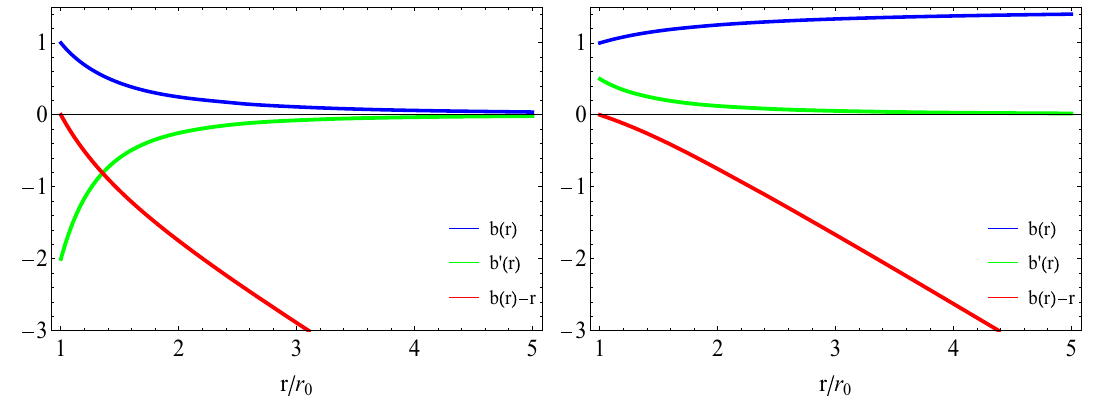
Fig. 2 These plots show the trend of the shape function (blue line), its first derivative (green line) and the curve b ( r ) − r defining the WH throat = 1 (left panel) and m = 0 and β = − r / 2 (right panel) (red line), for m = 1 and β = r 2 0 0 As shown Fig. 2 for the chosen m the shape function b ( r ) (blue line) remains finite everywhere. Moreover, the flare- out condition is also satisfied, it is depicted by the green line, where b (cid:9) ( r ) is always less than the straight line r = 1 at the neighborhood of the throat r 0 , and the blue line is representing the WH throat, as can be seen this curve cuts the radial axis just at r = 1 the throat of the WH